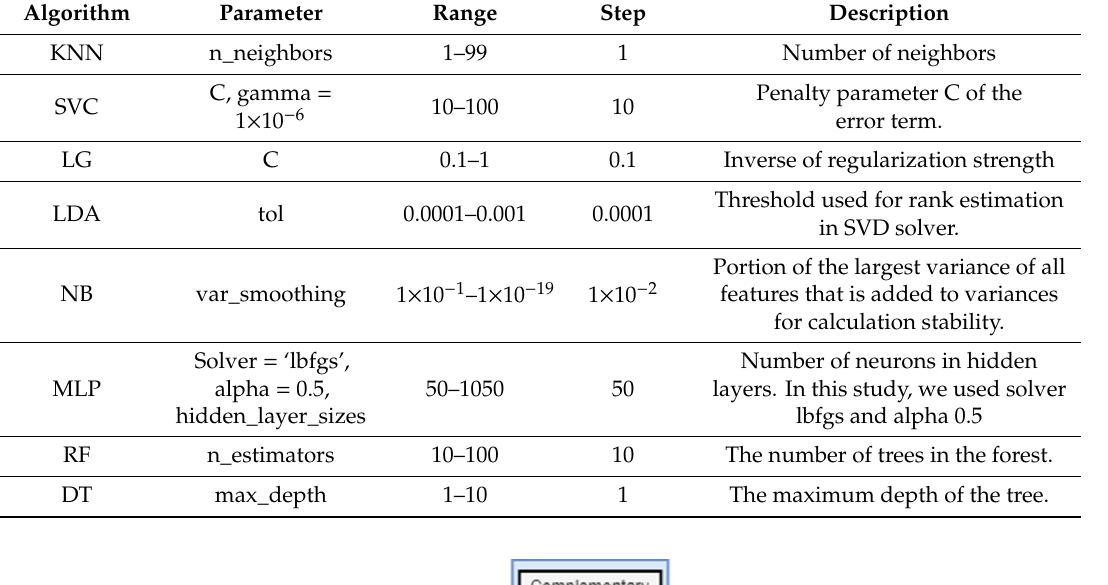
Table 3. Tested algorithm parameters.